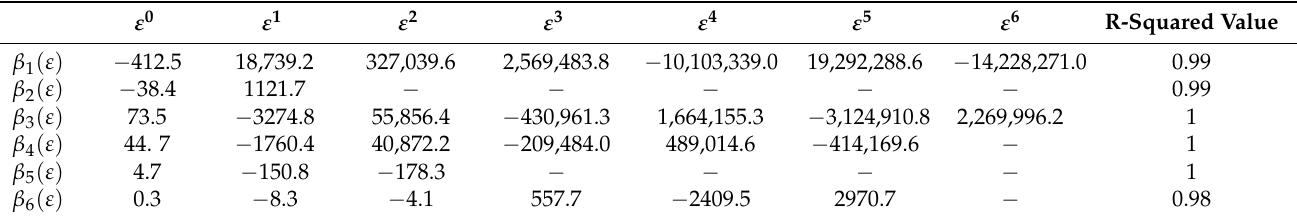
Table 2. The polynomial constants used in Equation